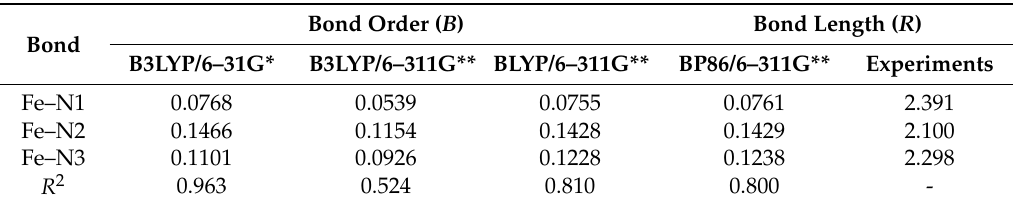
Table 7. The values of bond order ( B ) by different functional and basis sets and correlation results ( R 2 ) with bond lengths ( R ) from